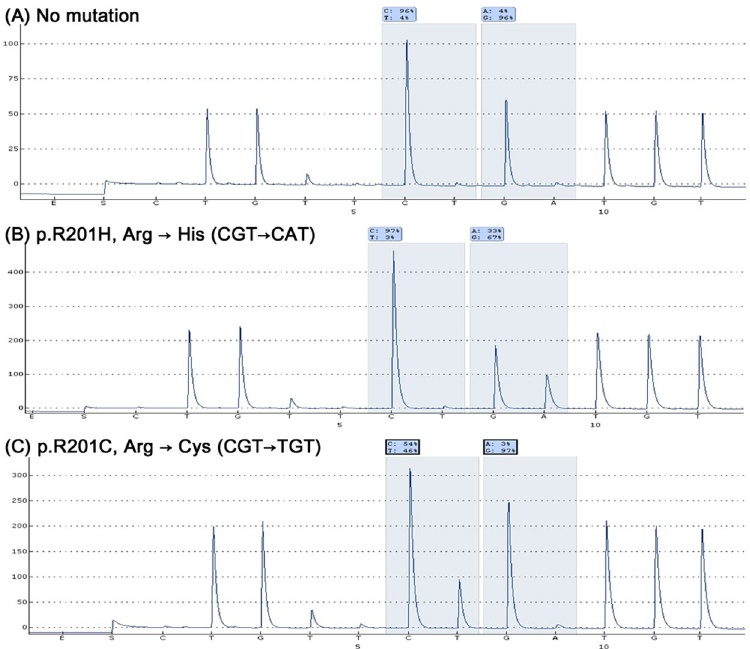
Figure 2. Typical pyrogram of ( A ) wild-type, ( B ) R201H (CGT → CAT), and ( C ) R201C (CGT → TGT) mutations of GNAS in fibrous